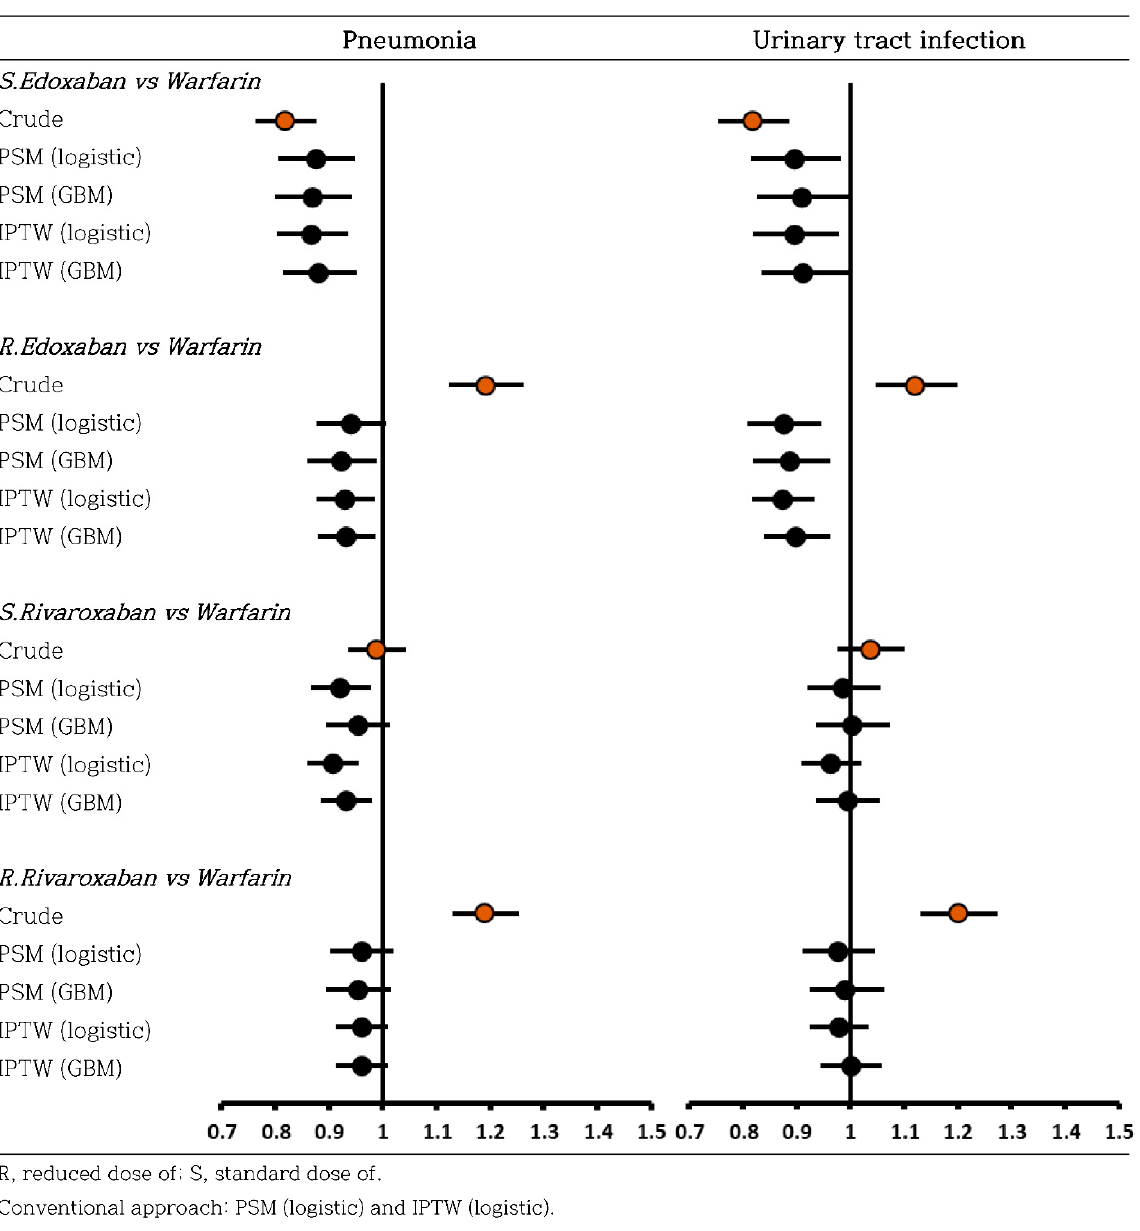
Figure 3. Hazard ratios for negative control outcomes.